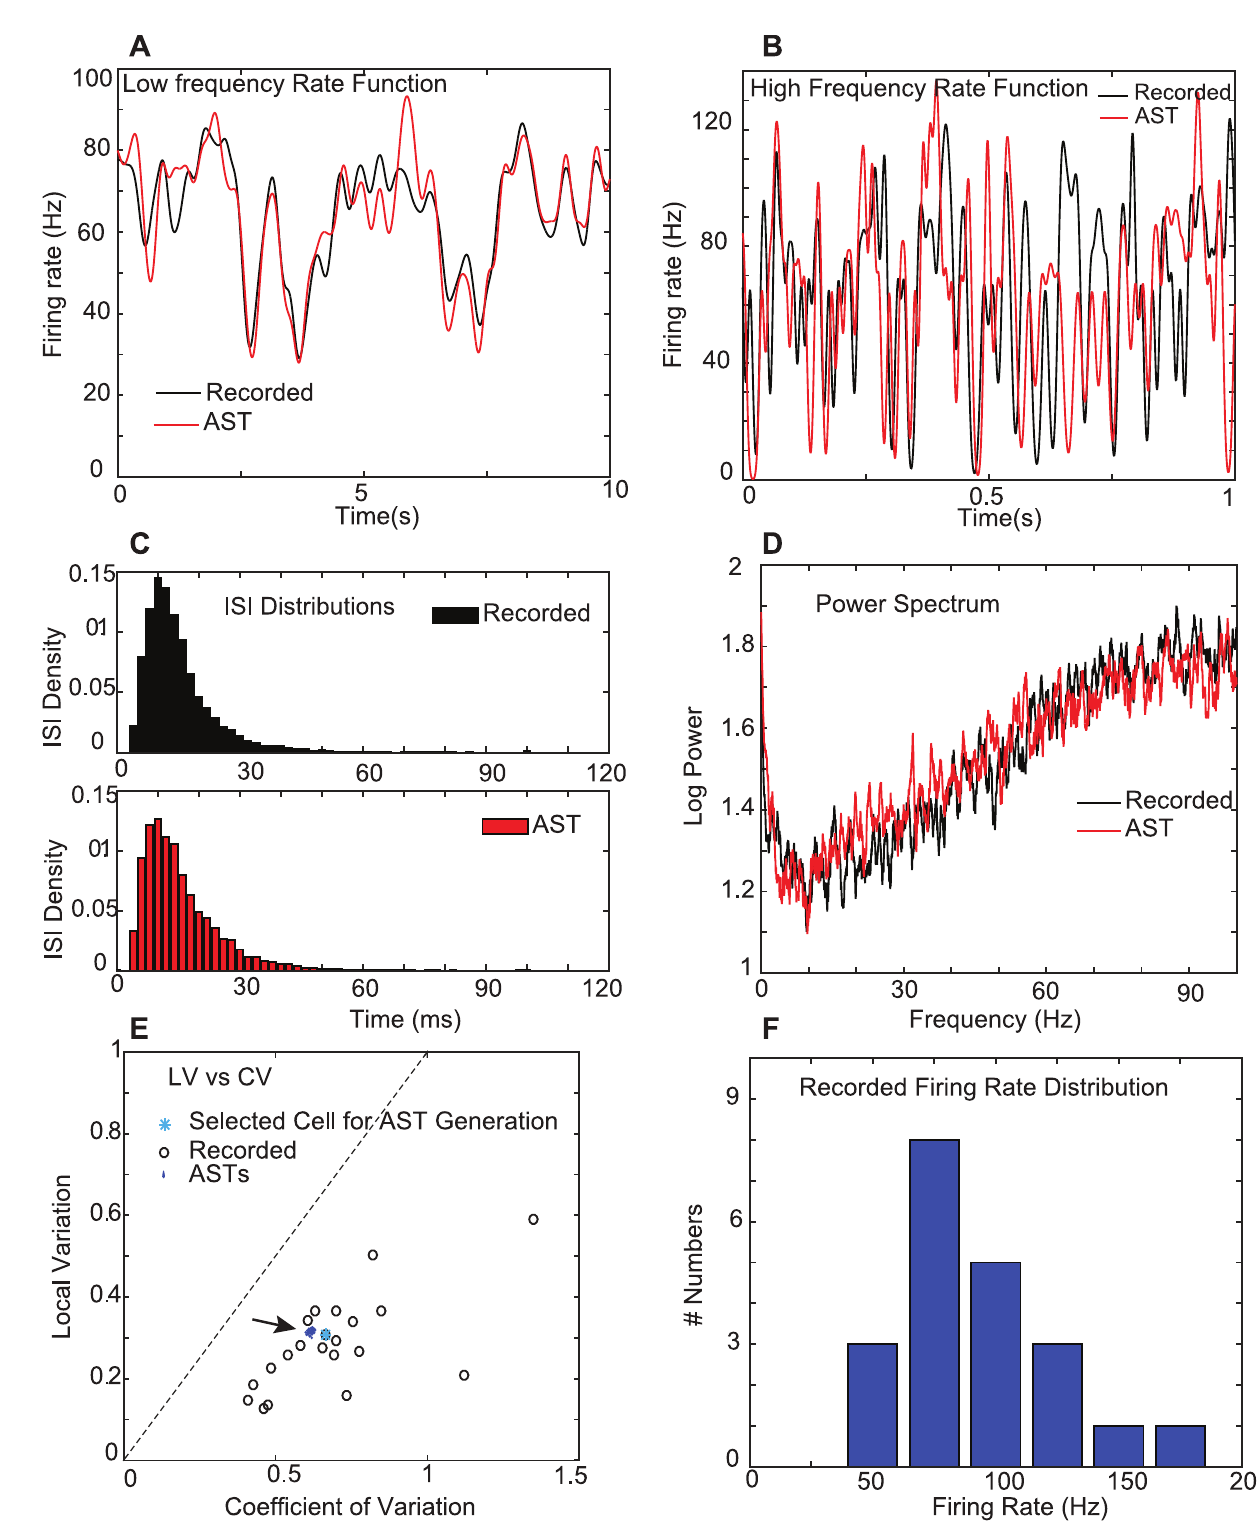
Fig 1. Purkinje cell AST construction from rate templates. MatchingAST propertieswith recordedPC spike trains. A. The slow rate function calculatedfrom a single recordedPC spike train (black) and of a sample AST sampledwith a gamma distributionfrom the adaptive Gaussian rate function of this PC (see Methods). The AST generallymatches slow rate modulations of the recordedPC. To highlightthis match